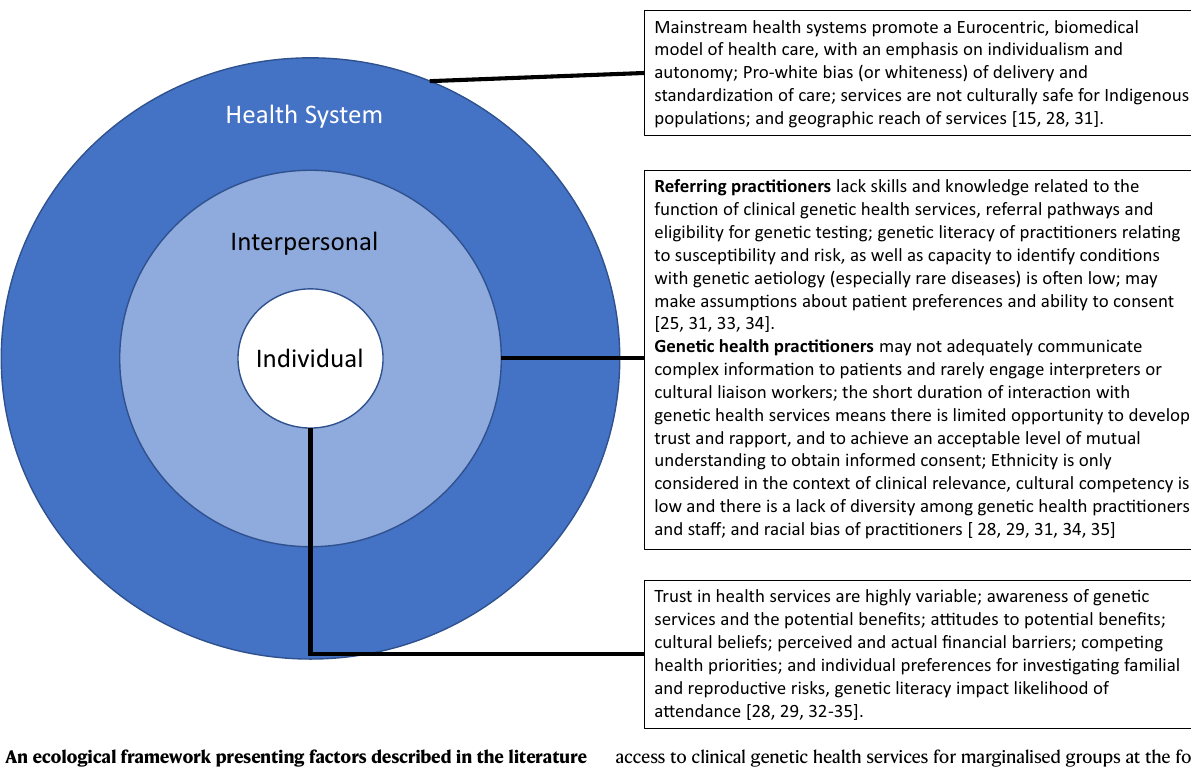
access to clinical genetic health services for marginalised groups at the following levels: Individual Interpersonal Health